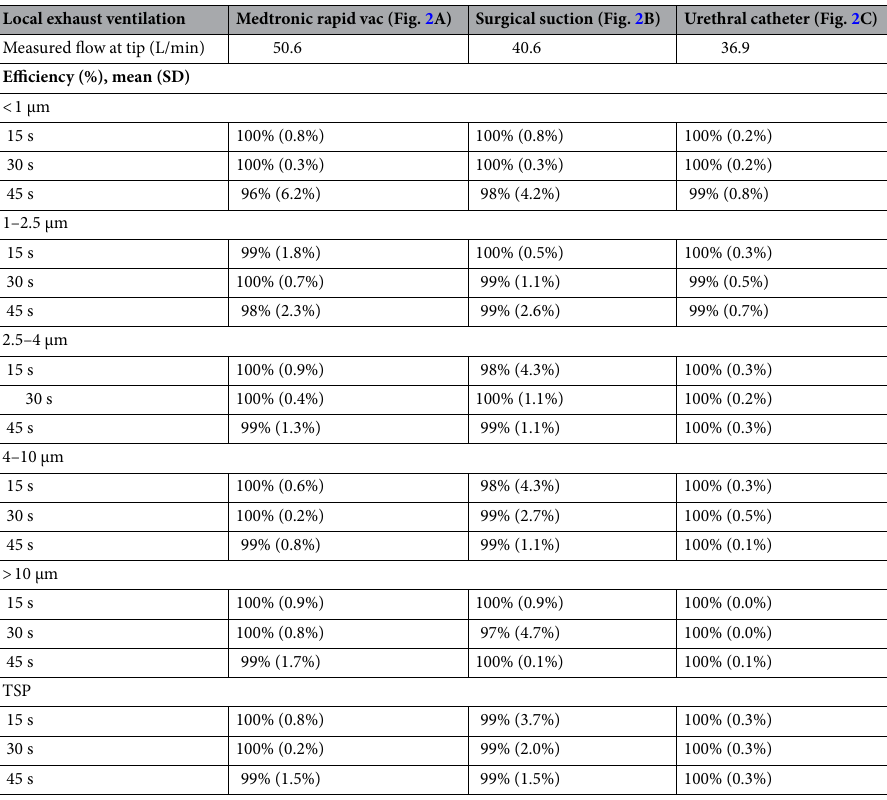
Table. 3. Comparison of smoke evacuation efficiency of different local exhaust ventilations under coagulation (power 30 W) with muscular tissue. TSP total suspended